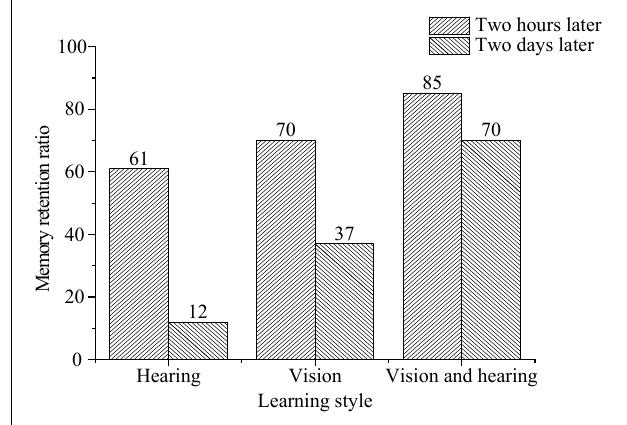
FIGURE 2 | Comparison of learning style and memory retention ratio (data comes from accenture: https://www.accenture.com/cn-zh).